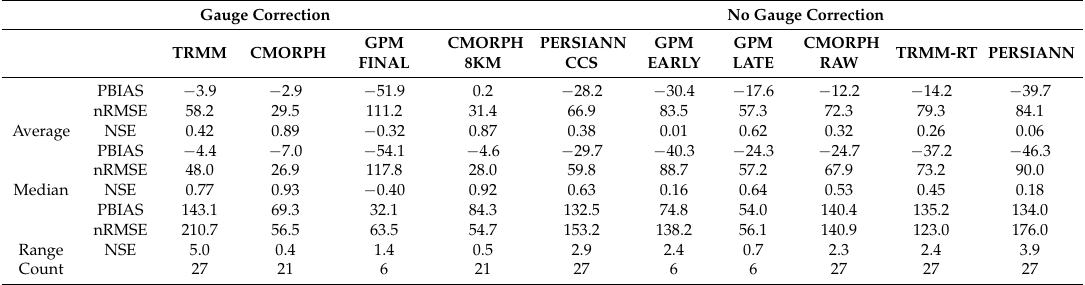
Table 3. Satellite hyetograph performance statistics aggregated across the three spatial